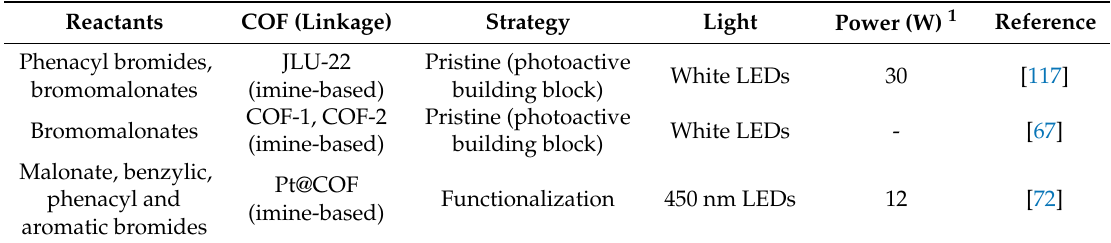
Table 15. Dehalogenation reactions mediated by COFs.